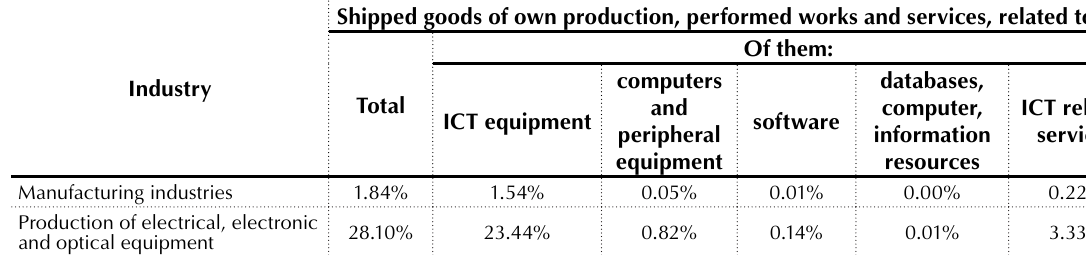
Table 4. Fourth stage: own production for ICT in Russia as of